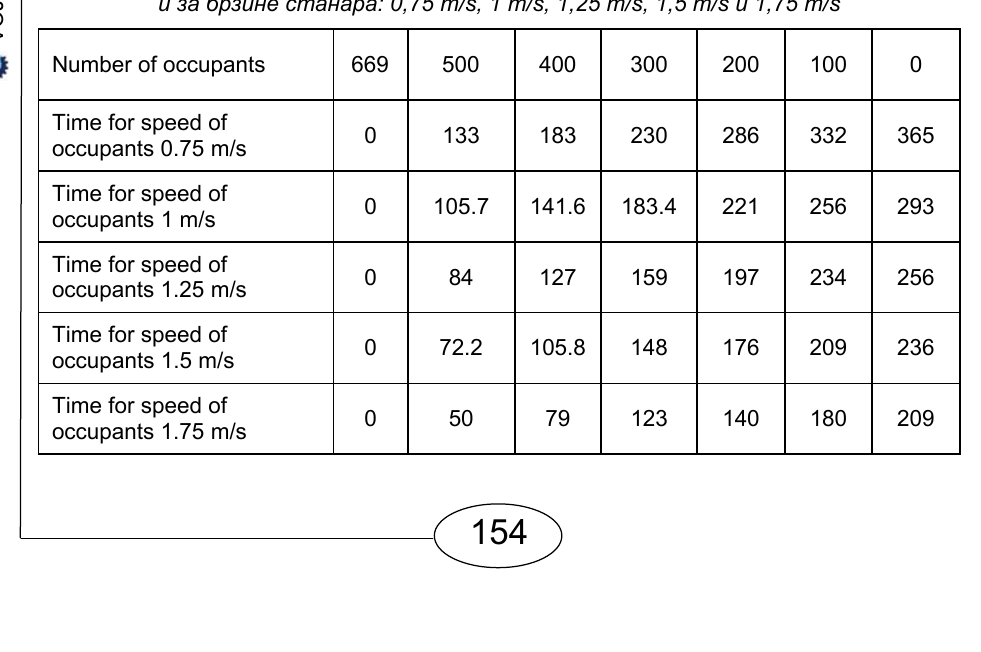
Figure 2 – Building in Bulevar Nemanji ć a Street, from 58 to 64 (a) and the Pathfinder simulation model of the residential building in Bulevar Nemanji ć a Street (b) Рис . 2 – Здание на Бульваре Неманича с 58 по 64 ( а ) и имитационная модель в жилом здании Pathfinder на Бульваре Неманича ( б ) Слика 2 – Зграда у Булевару Немањића , од броја 58 до 64 (a), и симулациони модел у Pathfinder- у стамбене зграде у Булевару Немањића ( б ) Table 1 – Simulation results in seconds for the first scenario, with elevators enabled and for the occupants’ speeds from 0.75 m/s, 1 m/s, 1.25 m/s, 1.5 m/s, and 1.75 m/s Таблица 1 – Результаты симуляции , выраженные в секундах по первому сценарию , с лифтами , учитывая скорость жильцов : 0.75 м / с , 1 м / с , 1.25 м / с , 1.5 м / с и 1.75 м / с Табела 1 – Симулациони резултати у секундама за први сценарио , са